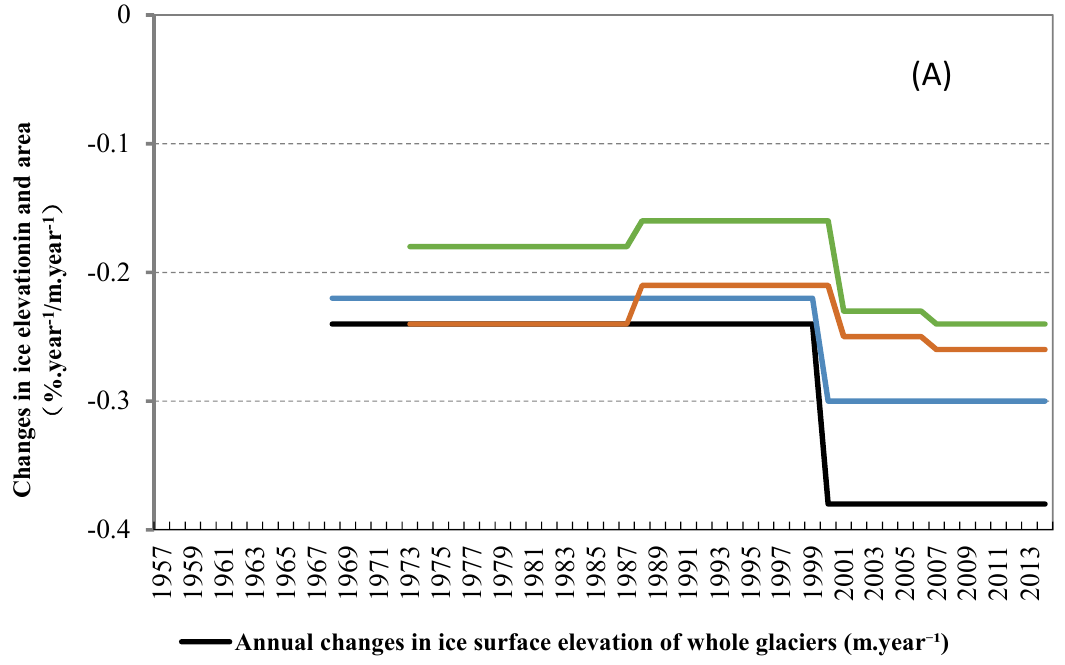
Annual changes in ice surface elevation of whole glaciers (m.year⁻¹) Annual changes in glacier area of whole glaciers (%.year⁻¹) Annual changes in ice surface elevation of non-surging glaciers (m.year⁻¹) Annual changes in glacier area of non-surging glaciers